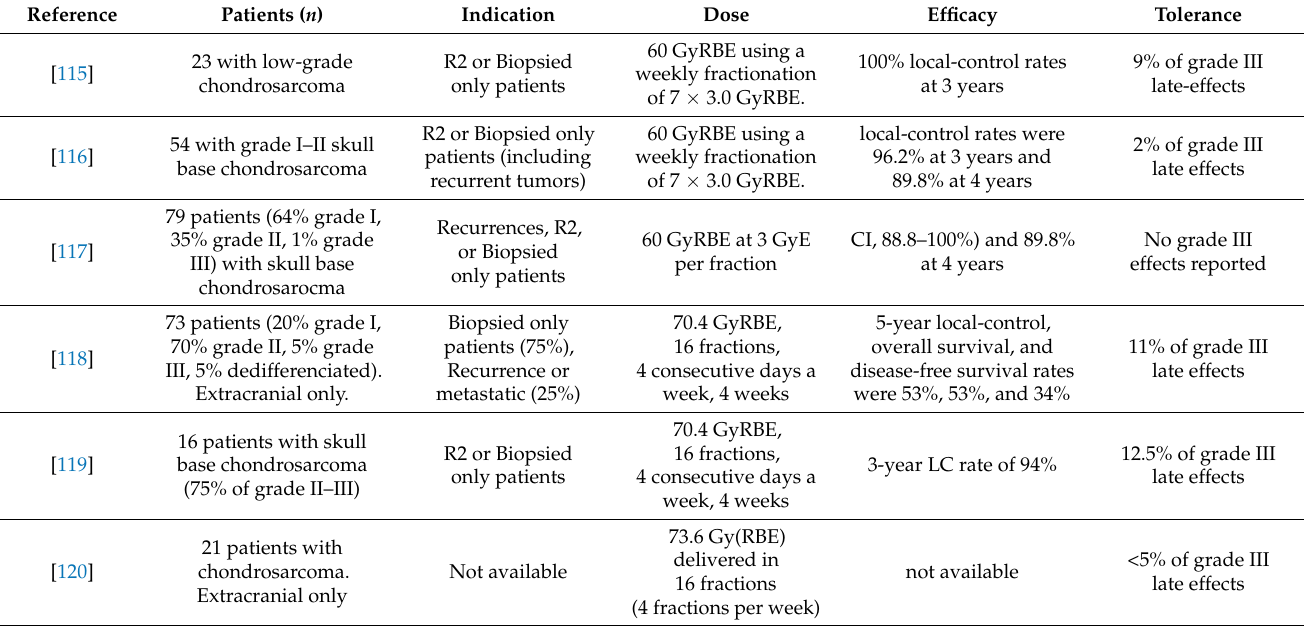
Table 1. Clinical studies involving chondrosarcoma patients (>10